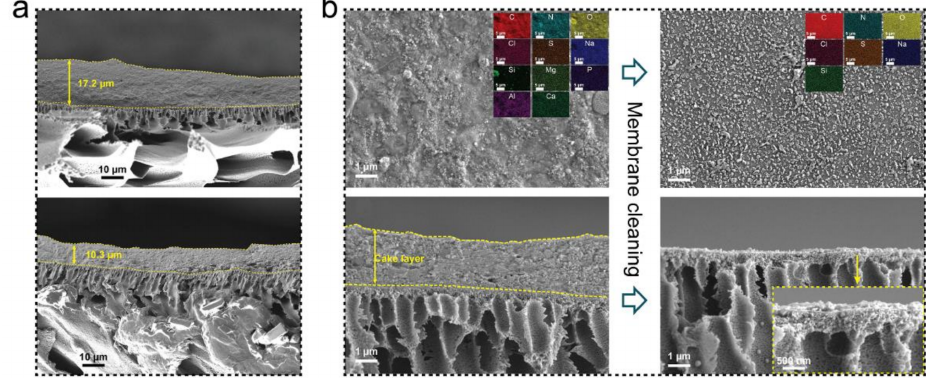
Figure 3. ( a ) SEM images of the cross-section of the FO (top) and GO-modified FO (bottom) mem- branes after 24 h filtration of sewage, and ( b ) surface (top) and cross-sectional (bottom) SEM of the GO-modified FO membrane before and after the last cleaning cycle, adapted from